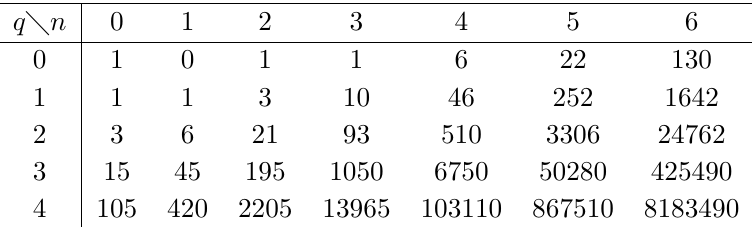
Table 3 . Number of distinct dipole graphs for q quark-antiquark pairs and n